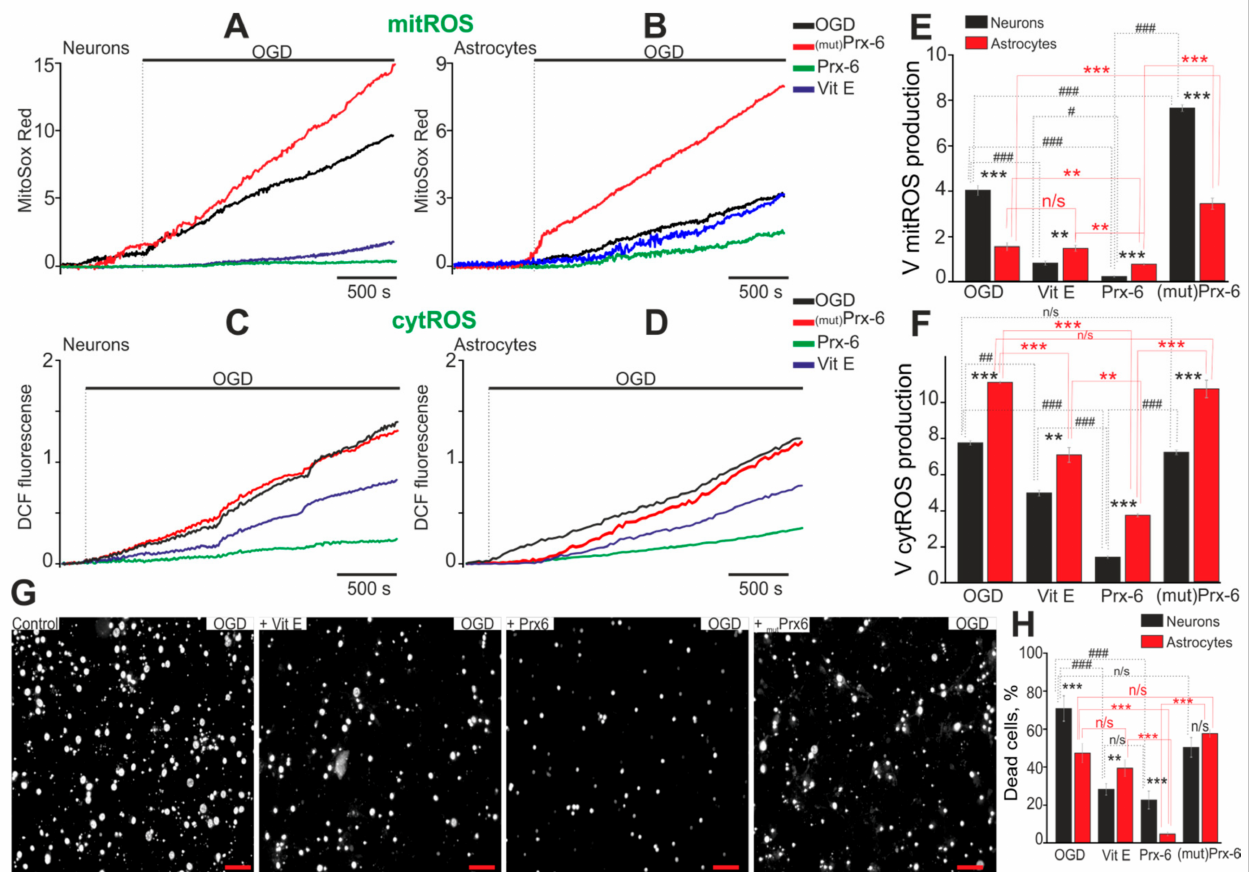
Figure 2. Effects of antioxidant enzyme Prx-6, mutant Prx-6 (mutPrx-6, Prx6-C47S) and natural antioxidant vitamin E (Vit E) on OGD-induced ROS production in mitochondria (mitROS), cytosol (cytROS) and cell viability. ( A , B ) Registration of ROS production in mitochondria of the neurons ( A ) and the astrocytes ( B ) during OGD (40 min) depending on a 24-h incubation of the cell cultures with Prx-6 (100 µ M), mutPrx-6 (100 µ M) and Vit E (100 µ M). ( C , D ) Registration of ROS production in cytosol of the neurons ( C ) and the astrocytes ( D ) during OGD (40 min) depending on a 24-h incubation of the cell cultures with Prx-6 (100 µ M), mutPrx-6 (100 µ M) and Vit E (100 µ M). Average curves plotted according to data on several dozen cells are represented. ( E , F ) Effect of the compounds under study on the rate of mitROS ( E ) and cytROS ( F ) production in hippocampal neurons and astrocytes. The average rates of ROS production within the interval from the point of OGD onset to the end point of the experiment are represented. ( G , H ) Effect of 24-h incubation with Vit E, Prx-6 and mutPrx-6 on the cell viability after 40 min OGD. Statistical significance was assessed using paired t -test. n/s—data not significant ( p > 0.05), ** p < 0.01, and *** p < 0.001; # p < 0.05, ## p < 0.01, ### p < 0.001. Scale bar = 30 µ